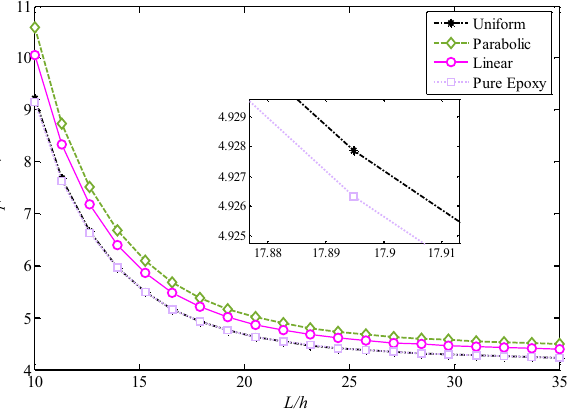
= 2 π , μ = 1, W = 0.01 ) . r U GNP